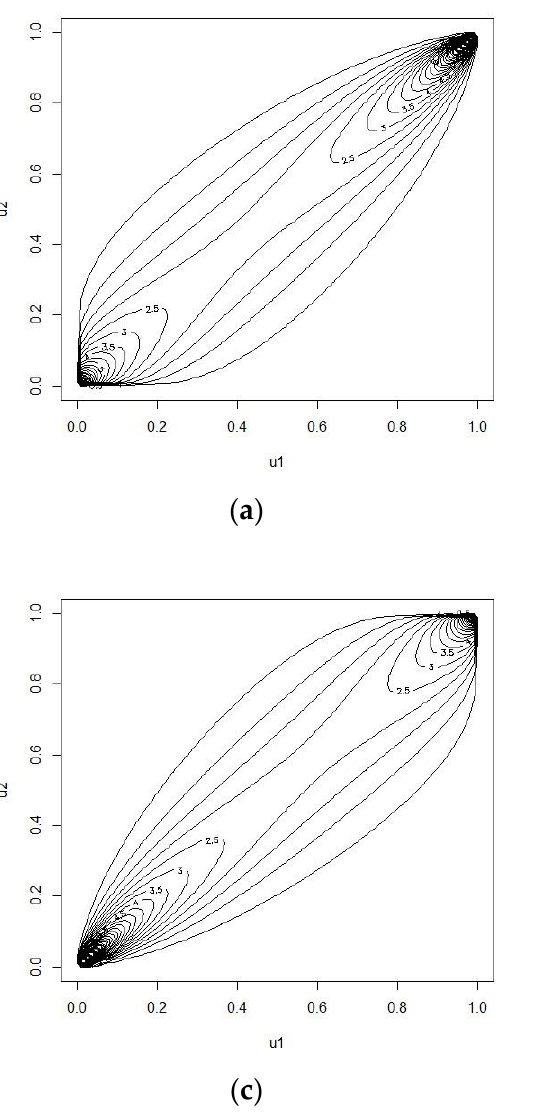
Figure A1. Gumbel copula contour plot with θ = 3. ( a ) Not rotated. ( b ) Rotated by 90 ◦ . ( c ) Rotated by 180 ◦ . ( d ) Rotated by 270 ◦